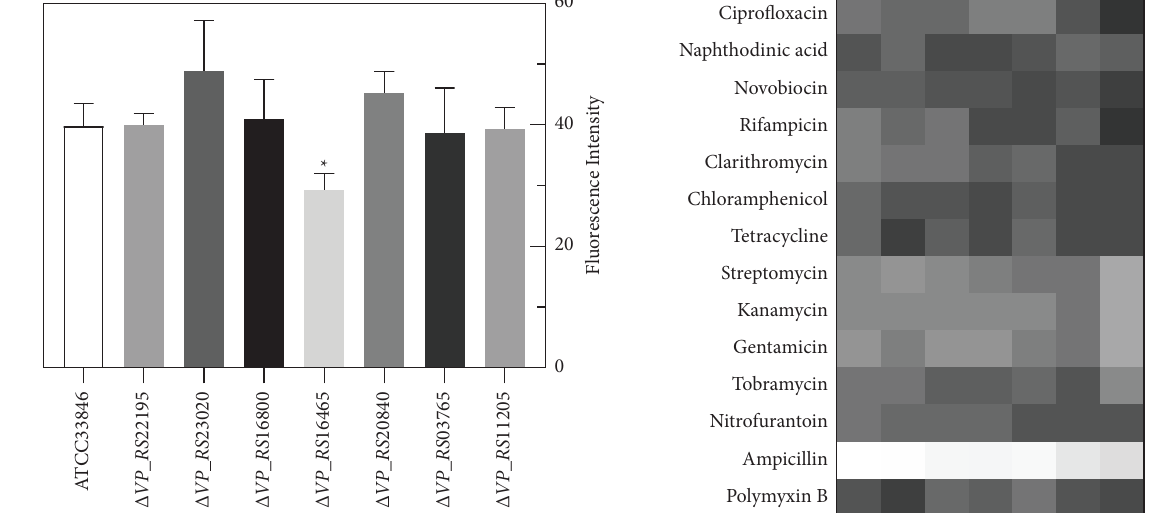
Figure 3: Comparison of OM permeability of the 7 V. parahaemolyticus OMP mutants, using wild-type ATCC33846 as a control. Te fuorescence intensity was determined with ex- citation at 350nm and emission at 428nm. Each bar represents the mean value of three biological replicates, and error bars represent standard deviations calculated from three biological replicates. A statistically signifcant diference was determined using in- dependent samples t -test analysis ( ∗ P < 0 . 05).